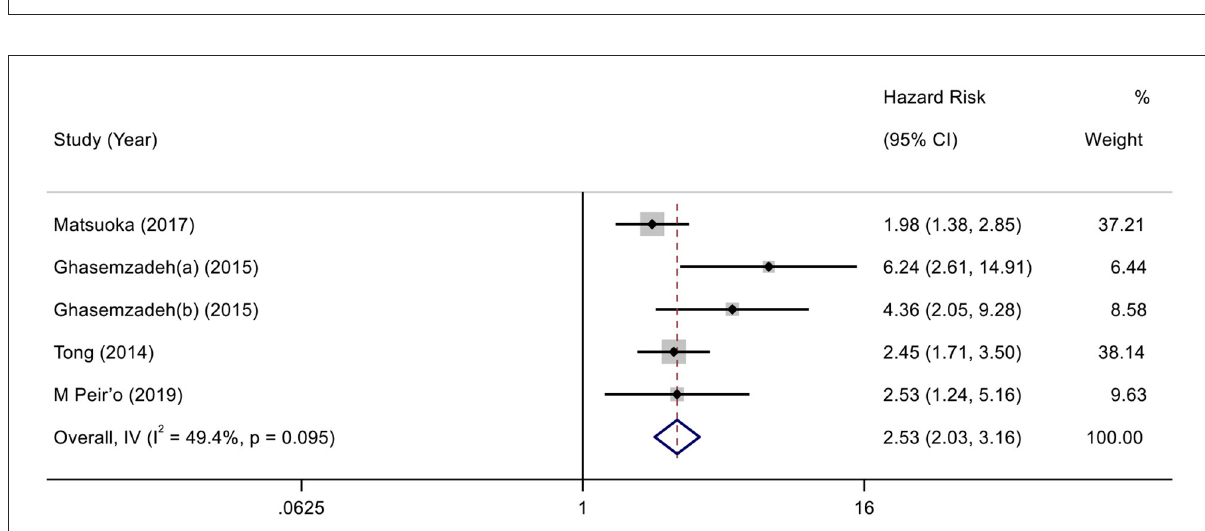
FIGURE3 Forest plot of the association between CXCL12 level as category variable and MACEs in patients with CAD (multivariate analysis).